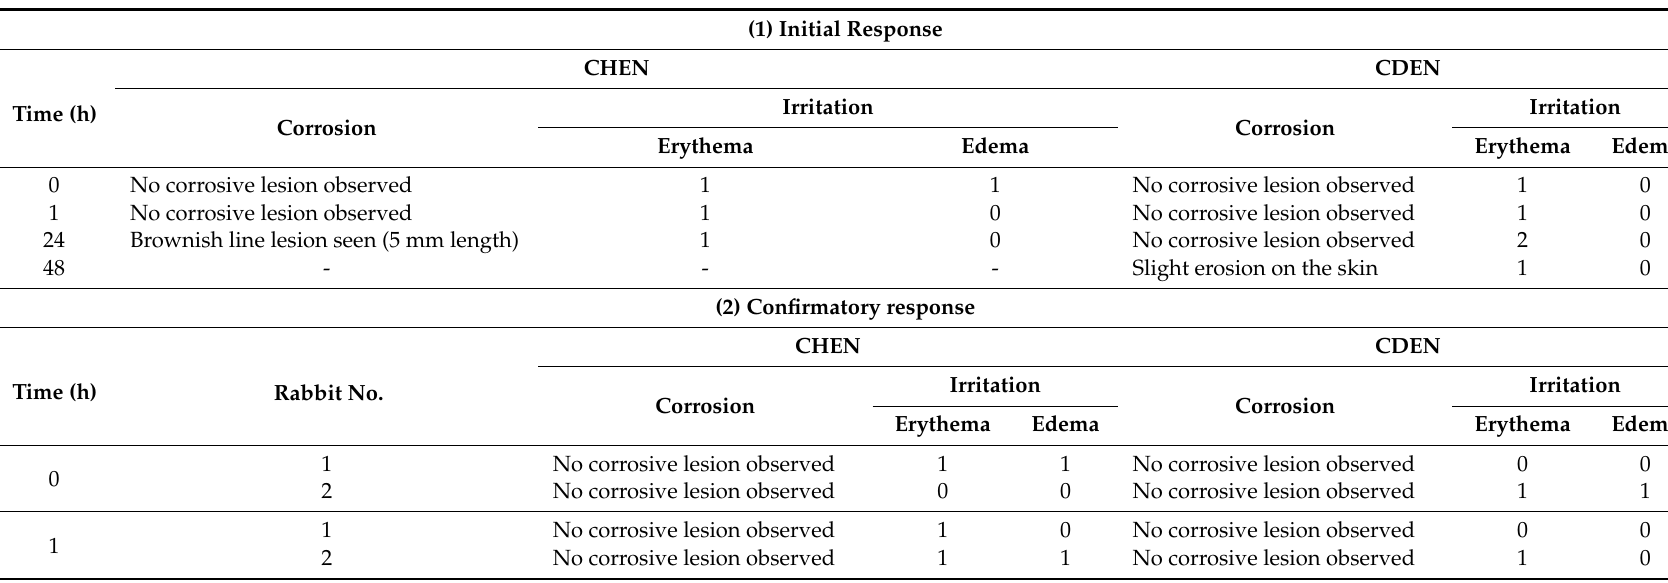
Table 5. Skin reaction scores of (1) the initial test (one rabbit) and (2) the confirmatory test (two rabbits) upon removal of patch, where time indicates the time after the removal of a patch and 0 h indicates the immediate observation upon removal of a